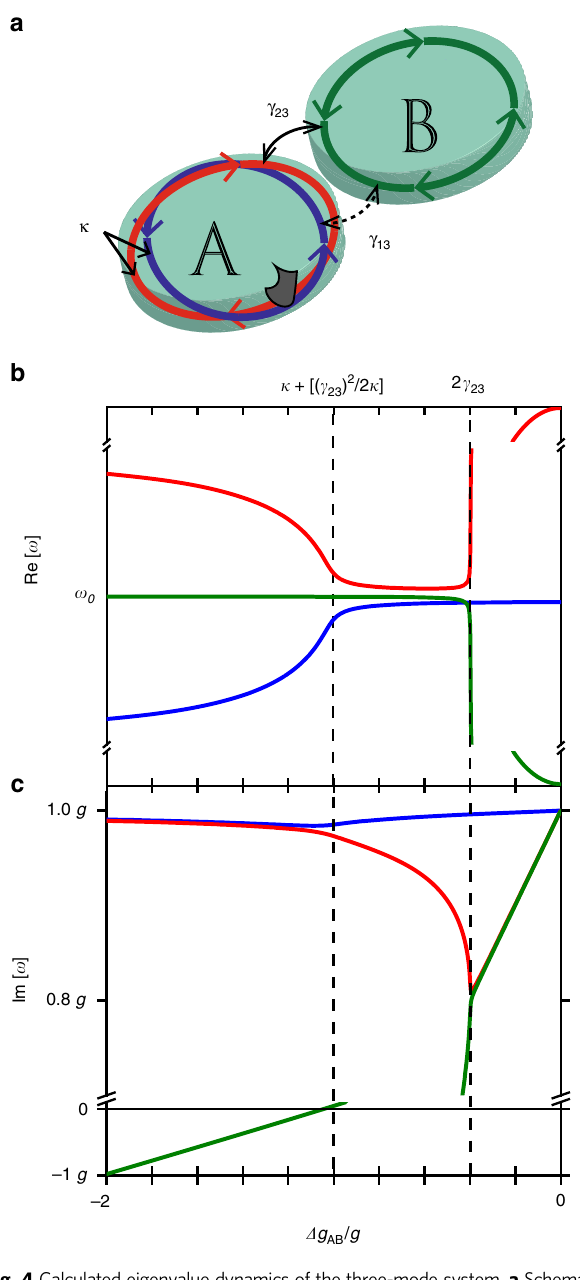
Fig. 4 Calculated eigenvalue dynamics of the three-mode system. a Schematic diagram of the modes considered and parameters governing their interaction. For microdisk A, a defect on the circumference (shown as the grey area) induces splitting between modes due to their mutual asymmetric backscattering determined by the parameter κ . These two modes can then couple to the degenerate modes in microdisk B through the inter-disk coupling parameters, γ 13 and γ 23 . We consider the case for which γ Real and Imaginary parts of the eigenvalues of the three-mode Hamiltonian vs. the normalized gain differential, Δ g AB / g between microdisks A and B. The dashed lines indicate the locations of the exceptional points EP 1 and EP 2 . The limiting values of the eigenvalue splitting are 2 κ at Δ g AB = − 2 g and 2 γ 23 at Δ g = 0, while the minimum splitting between EP1 and EP2 is γ AB